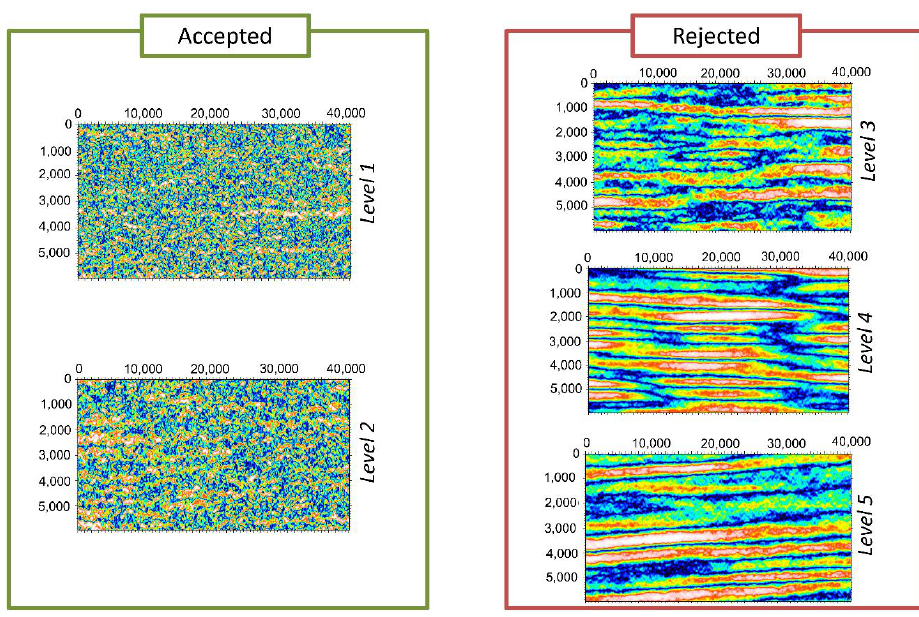
Figure 9. Topography of the autocorrelation function quarters for the five levels of roping (the X and Y axis units are micrometers).